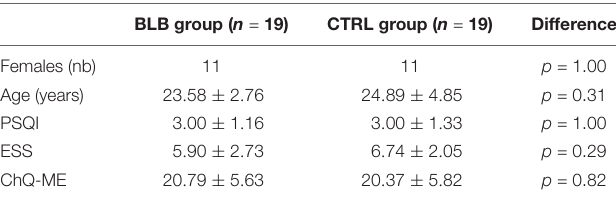
TABLE 1 | Demographic and questionnaire